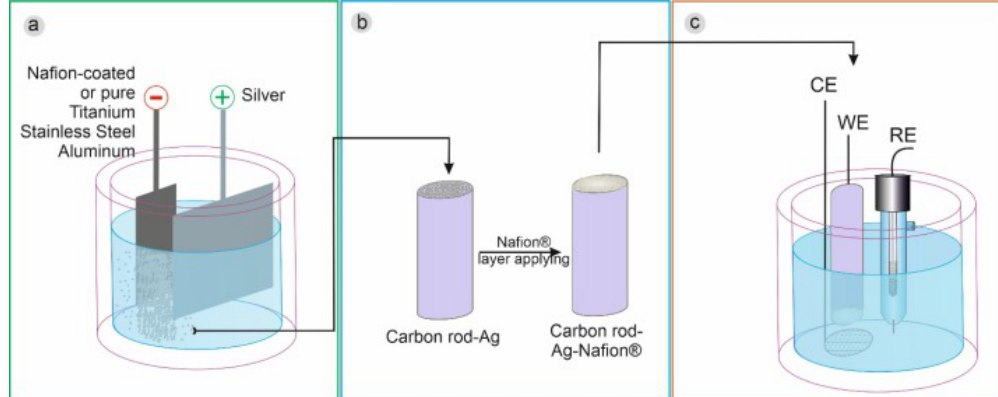
Figure 5. A general scheme for the synthesis of silver particles ( a ), their immobilization on the carbon rod electrode ( b ), and electrode utilization as a H 2 O 2 sensor ( c ). With permission from